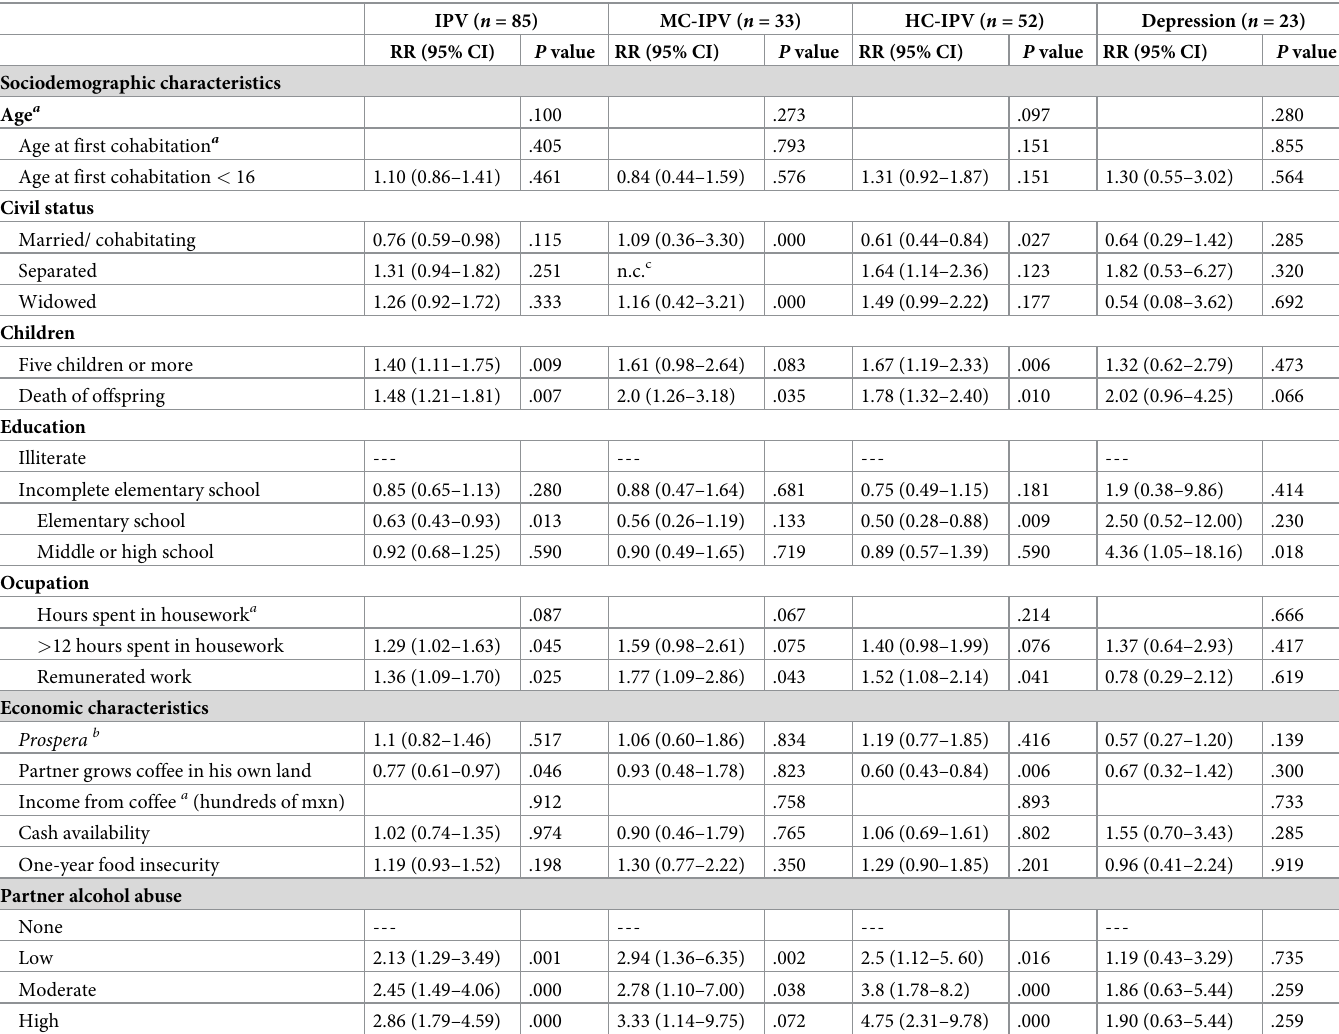
Table 3. Association of demographic, economic and partner alcohol abuse characteristics of participants with types of IPV and depression ( n =